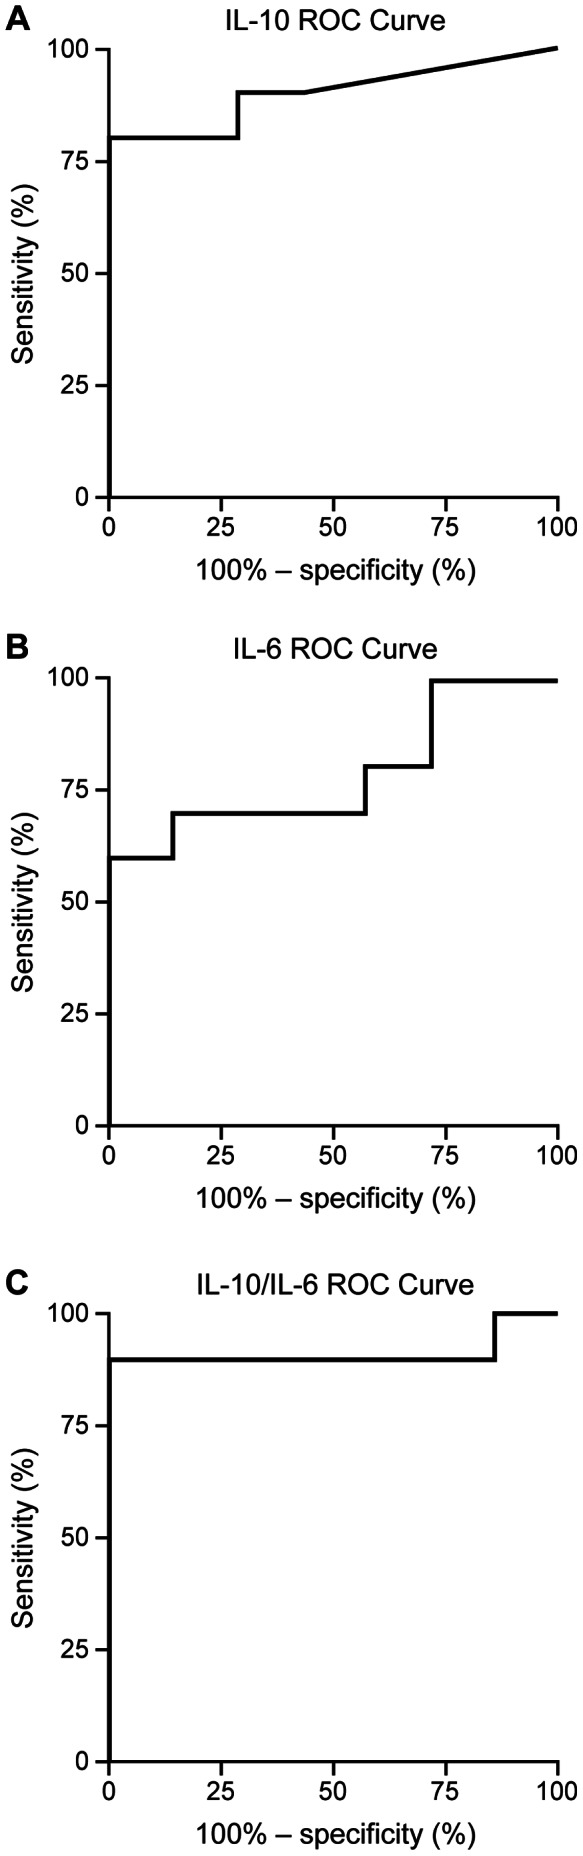
Empirical ROC curve using IL threshold values.a) IL-10 ROC curve, b) IL-6 ROC curve, c) IL-10/IL-6 ROC curve. The vertical axis represents the true positive rate (sensitivity), and the horizontal axis represents the false positive rate (1-specificity). The curve was generated by dichotomizing IL values into one of two groups (i.e., lymphoma vs. no lymphoma) to determine statistical indices associated with discrete threshold values.